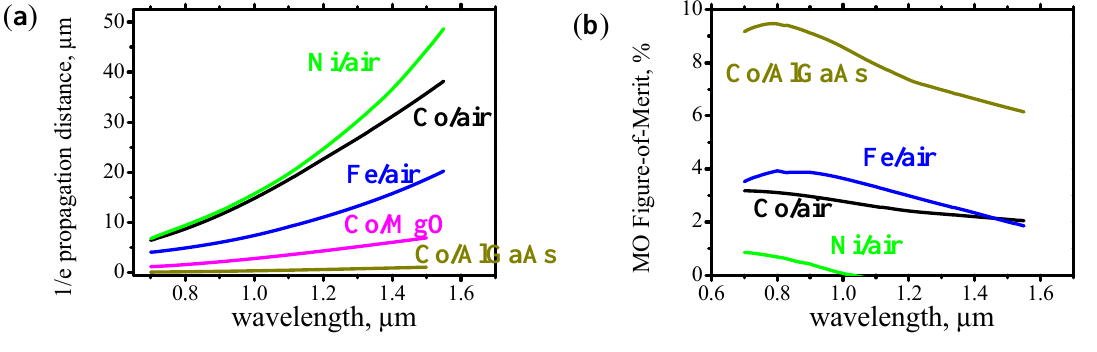
Figure 2. ( a ) 1/e propagation distance, and ( b ) magneto-optical Figure-of-Merit for optical plasmons propagating along Ni/air, Co/air, Fe/air, Co/MgO and Co/Al